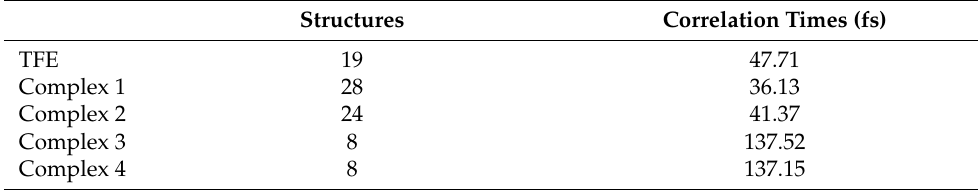
Table 4. Number of structures of the molecules selected by the SI method.